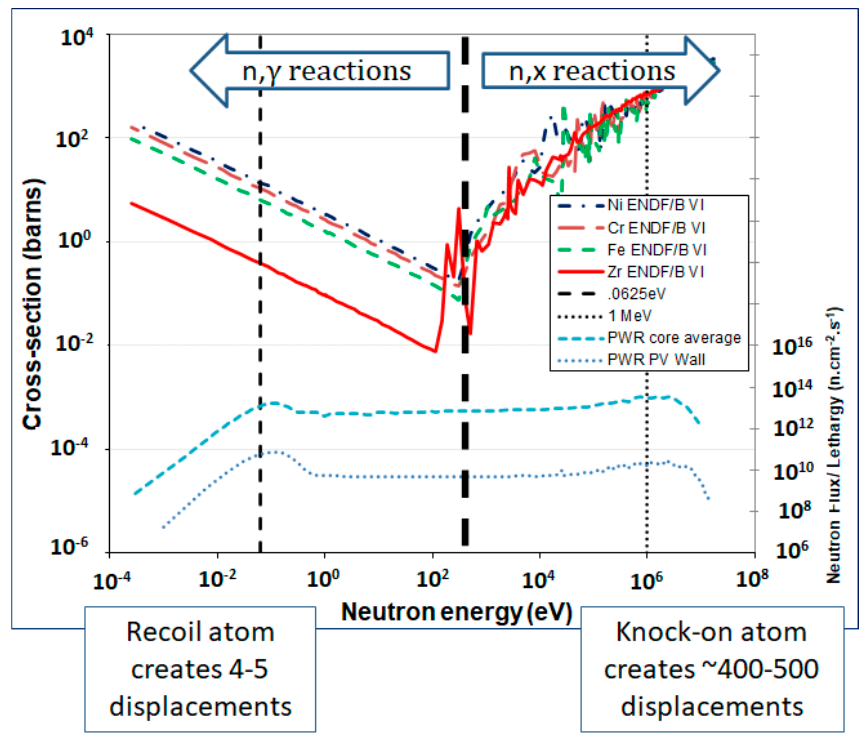
Figure 2. Atomic displacement cross sections as a function of neutron energy (left hand scale) and neutron spectra in a PWR (right hand scale).